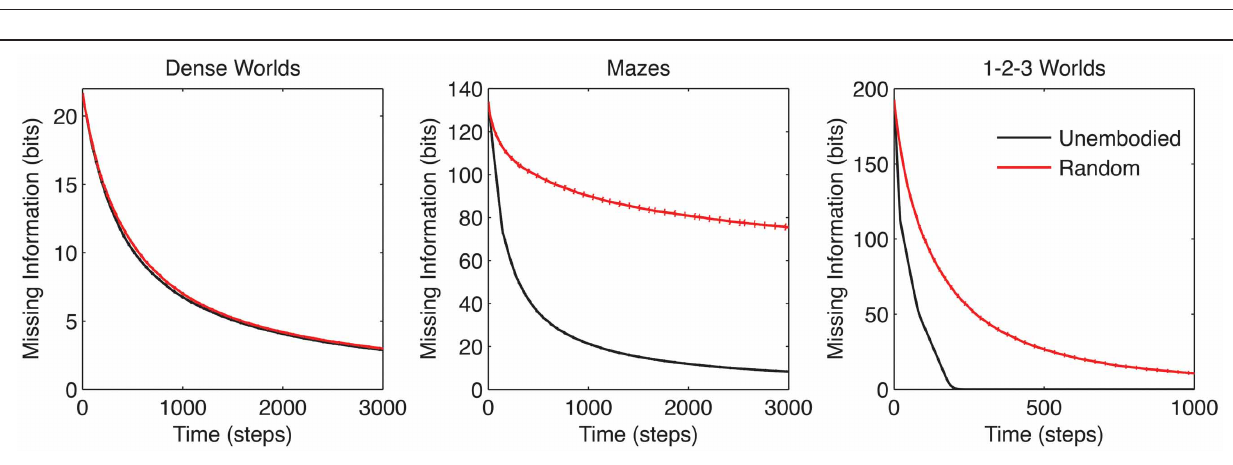
FIGURE 2 | Accuracy of predicted information gain. The average predicted information gain is plotted against the average realized information gain. Averages are taken over 200 CMCs, N × M transition distributions, and 50 trials. Error bars depict standard